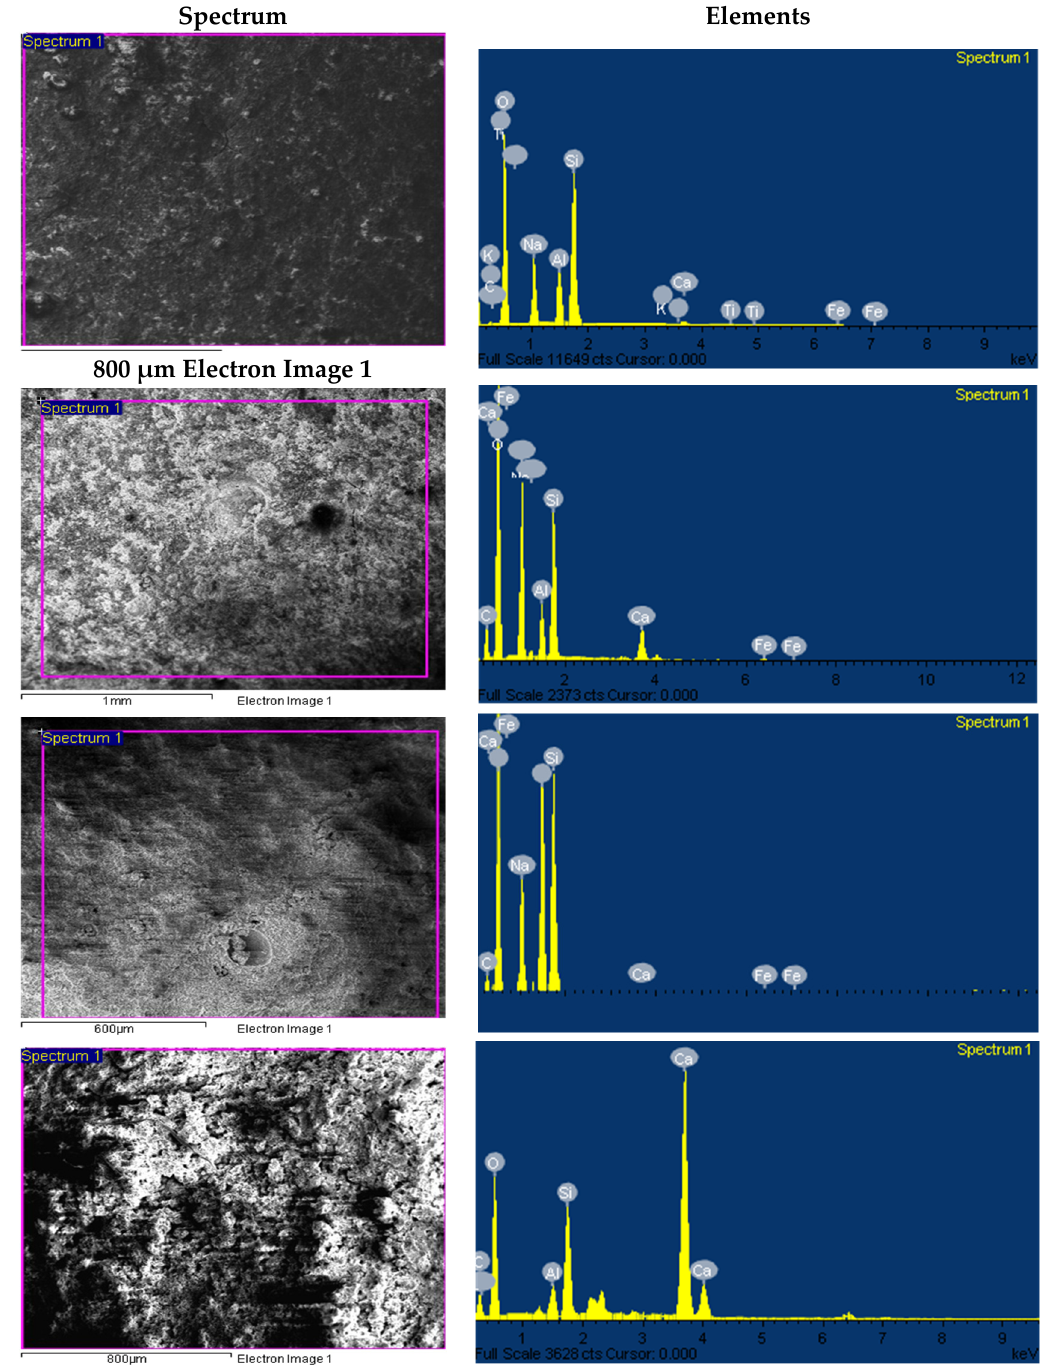
Figure 11. EDX spectrum of pastes at 7 days.